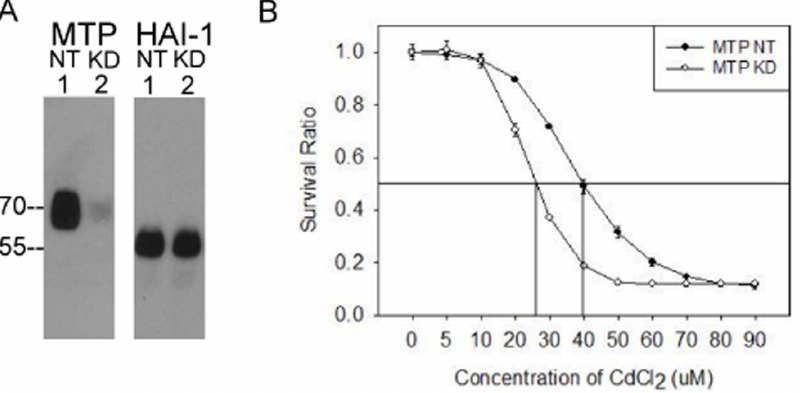
Figure 7. Knockdown of matriptase expression increases susceptibility to CdCl 2 toxicity. ( A ) Evaluation of matriptase and HAI-1 expression in matriptase knockdown (KD) and non-target (NT) control cells using immunoblot analyses of cell lysates to detect total matriptase (MTP) or HAI-1 (HAI-1). ( B ) Survival rates of matriptase knockdown cells (open circles) in comparison to non-target (NT) control cells (closed circles). Each cell pool was exposed to various concentrations of CdCl 2 , and survival ratios determined by crystal violet staining assay. The results from one representative experiment out of four replicates are shown.